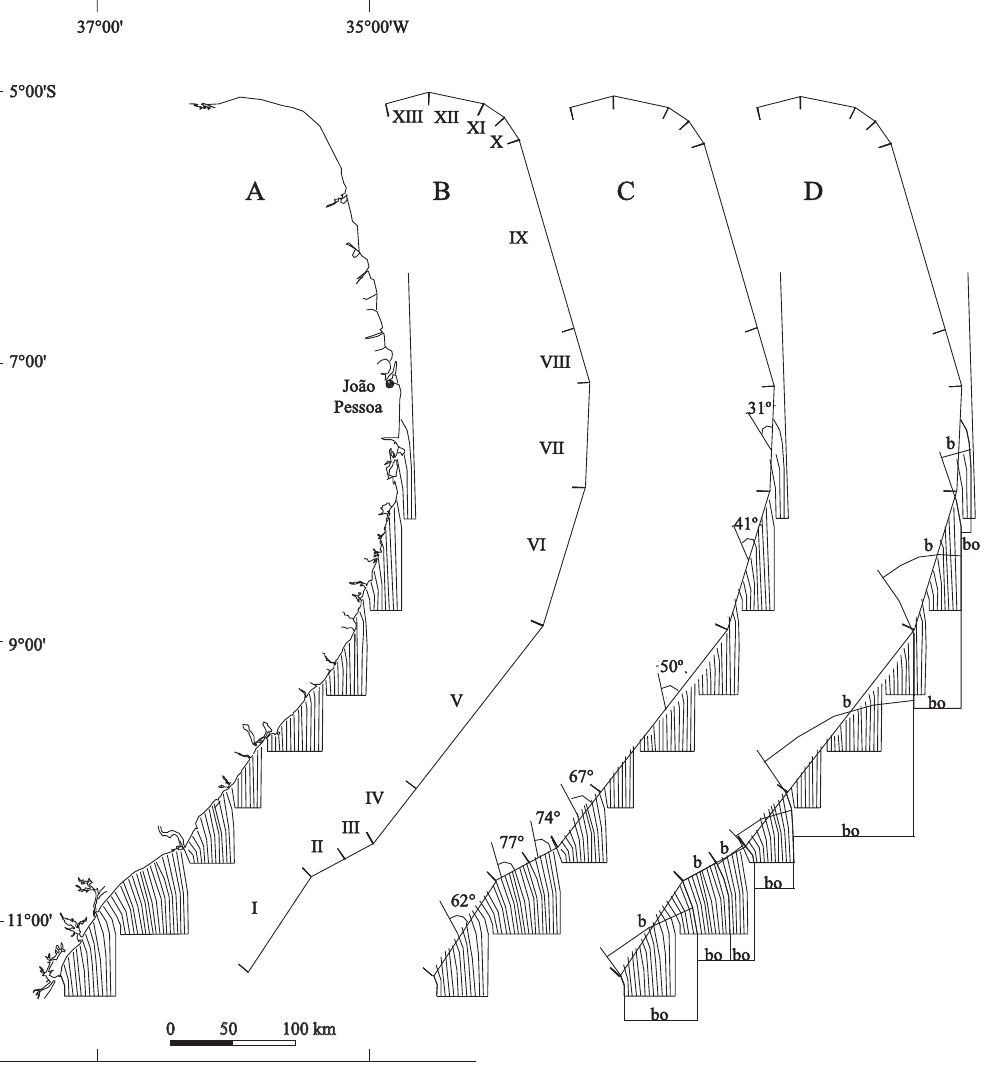
Fig. 5 – A – Refraction diagram for waves with a 6.5 sec period, arising from the S ( N180 ◦ ) . B – Different segments in which the coastline has been rectilinearized. C – Incidence angles formed by waves from S in relation to the rectilinearized coastal segments. D – Measurements of b and b o for estimating the height of waves along the rectilinearized coastal segments.